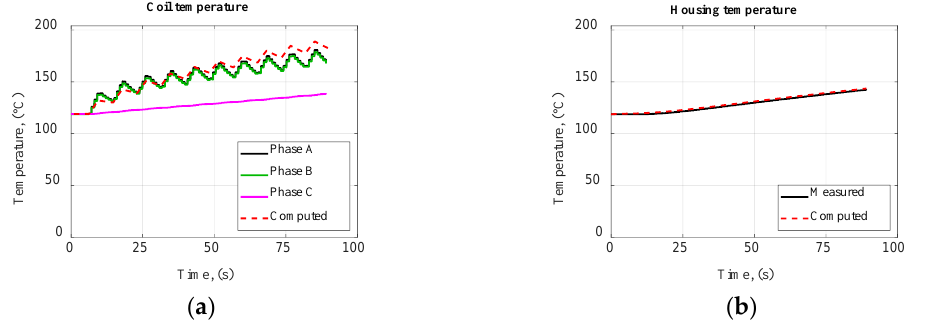
Figure 12. Measured and computed temperatures in the three phases ( a ) and in the housing ( b ) for the load cycle test 1.